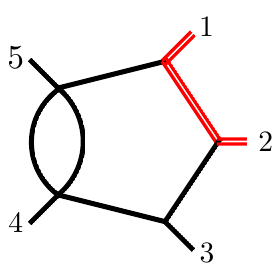
Figure 6 . The pentagon with a bubble insertion covers the master integrals I 16 and I 17 .